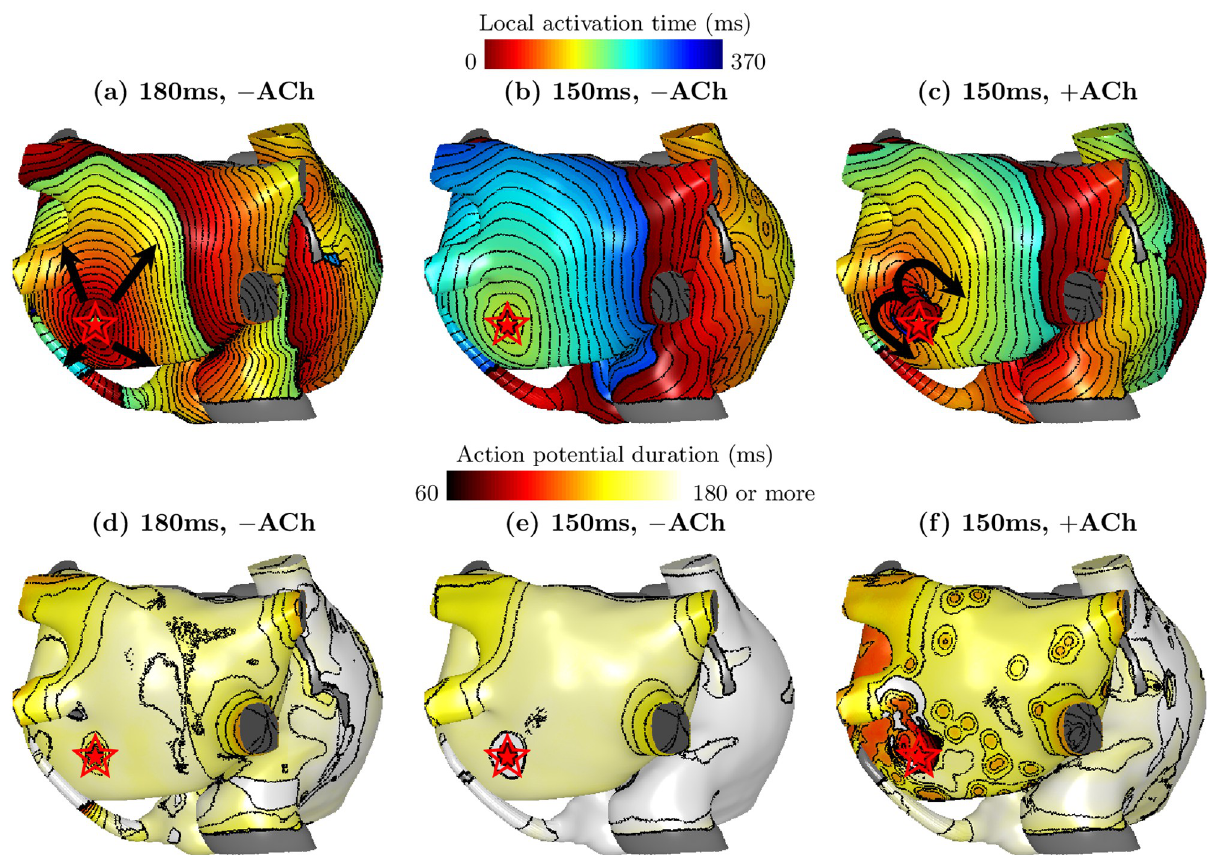
Fig 4. Local activation time maps (a–c) and action potential duration maps (d–f) following a discharge of an FS (red stars) from the same site on the LA posterior wall ( α = 0.4, β = 0.2), on the atrial mesh of Patient 1, under focal cycle lengths of 150 ms and 180 ms, with (“+”) and LA LA without (“ − ”) ACh. The directions of wavefront propagation from the FS were shown by the black arrows. A gray color indicates tissue that was not excitable. Isochrone lines are drawn at an interval of 10ms. The focal activation was propagated at (a) and (c) but was blocked at (b). (f) shows the highest spatial heterogeneity in the action potential duration.